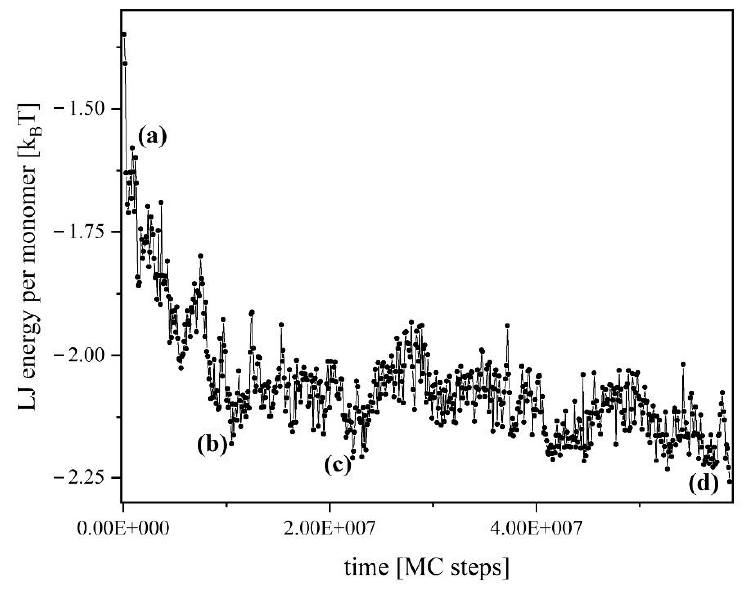
Figure 7. Evolution of the LJ interaction energy per monomer toward Kagome cocrystal structure. Energy corresponding to the snapshots configurations taken from Figure 6 ( a – d ) is indicated, too.